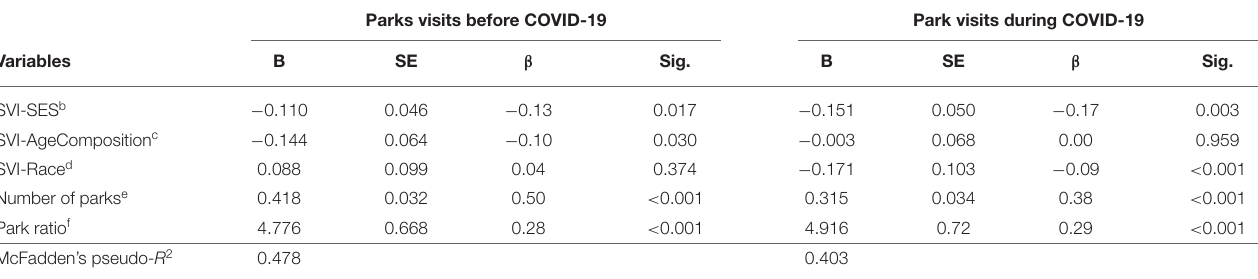
TABLE 4 | Results of negative binomial regression models a investigating associations between various census tract-level measures of social vulnerability (based on the social vulnerability index, SVI) and total park visits before and during the COVID-19 pandemic in North Carolina (NC), USA. Parks visits before COVID-19 Park visits during COVID-19 Variables B Sig.